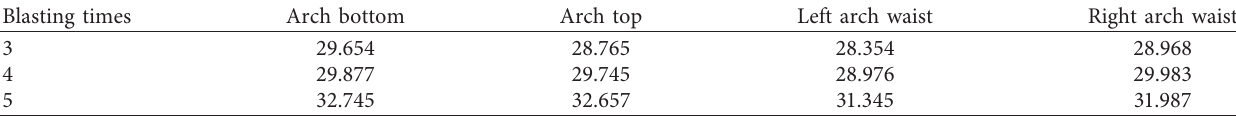
Table 9: The cumulative value of displacement of each measuring point of profile 1-1 without initial support (mm).